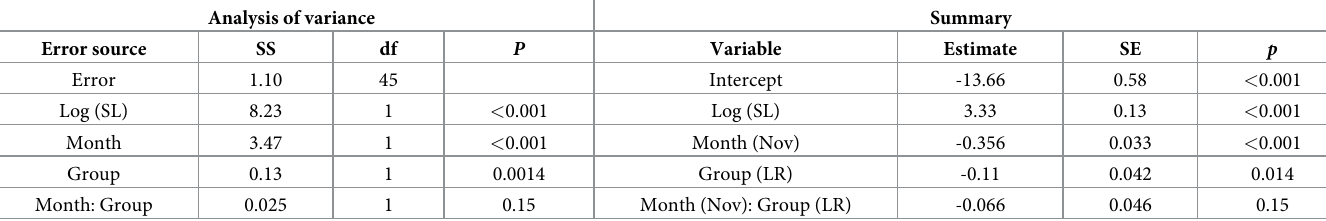
Table 2. Results of the linear model for log (body weight) of western sand lance ( Ammodytes japonicus ) in Experiment II. Analysis of